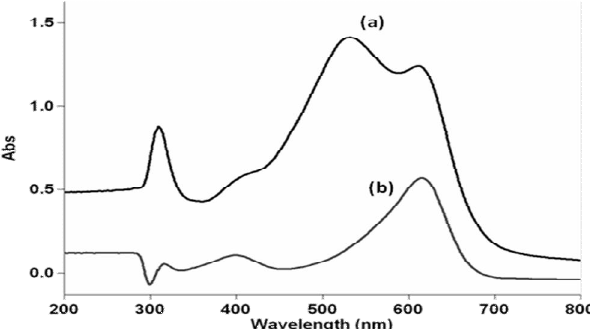
Fig. 8. Efficiency of the wastewater treatment for real sample spiked with BCG and bromocrosol green (UV-Vis absorbance a: before and b: after